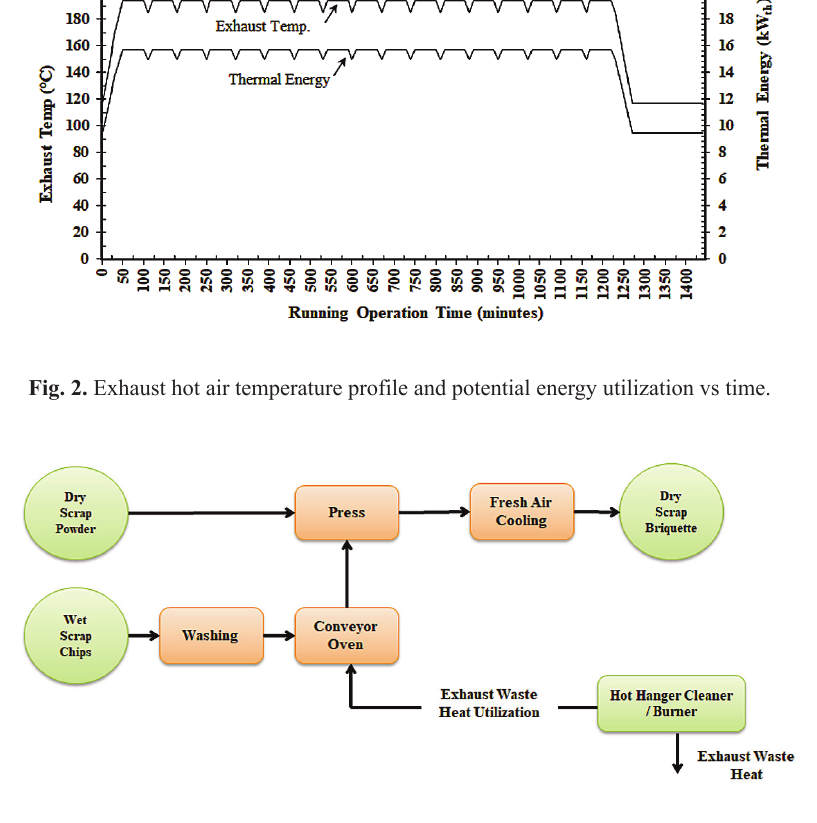
Fig. 3. The flow design concept for exhaust hot air use.